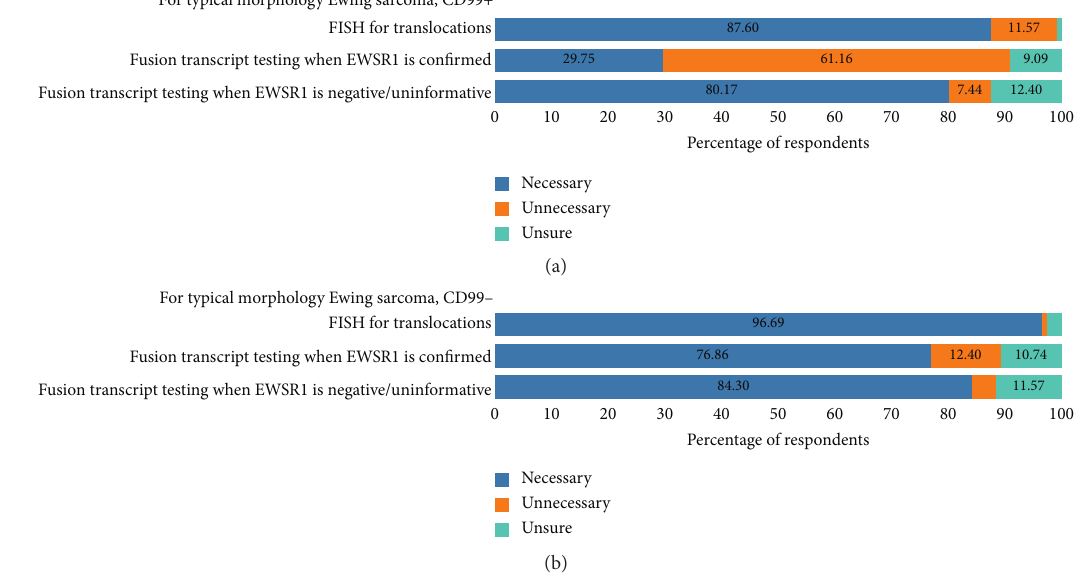
Figure 5: Summary of suggested workup for patients with defined diagnostic features: (a) respondents’ opinions regarding the necessary diagnostic workup for a case of a CD99+, typical Ewing morphology tumour. (b) Respondents’ opinions regarding the necessary diagnostic workup for a case of a CD99 − , atypical Ewing morphology